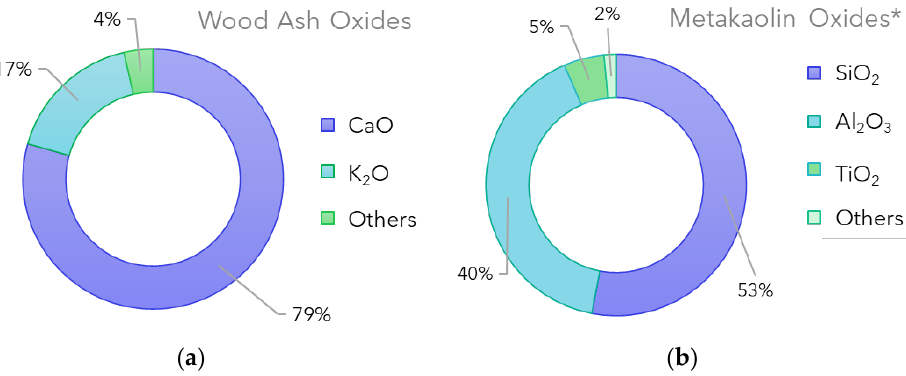
Figure 3. Metal oxides percentage present in ( a ) wood ash and ( b ) metakaolin. *Average values were adapted from [27].